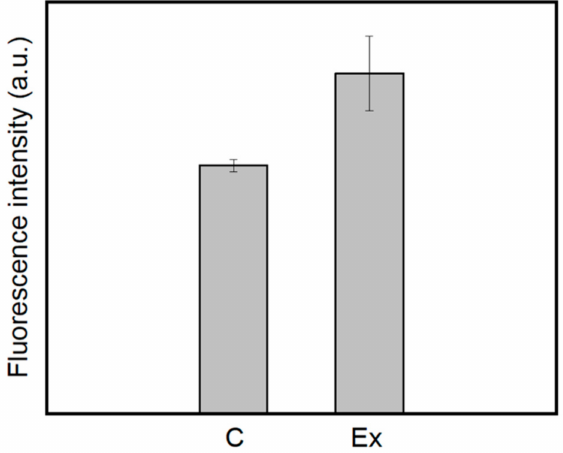
Figure 10. Fluorescence intensity of extracellular · OH generated at 4 h. C was a control group containing isopropyl alcohol ( · OH scavenger), terephthalic acid, and Cu-VO. Ex was an experimental group containing terephthalic acid and Cu-VO. · OH assay was performed three times, and the plot was the average of three independent results.